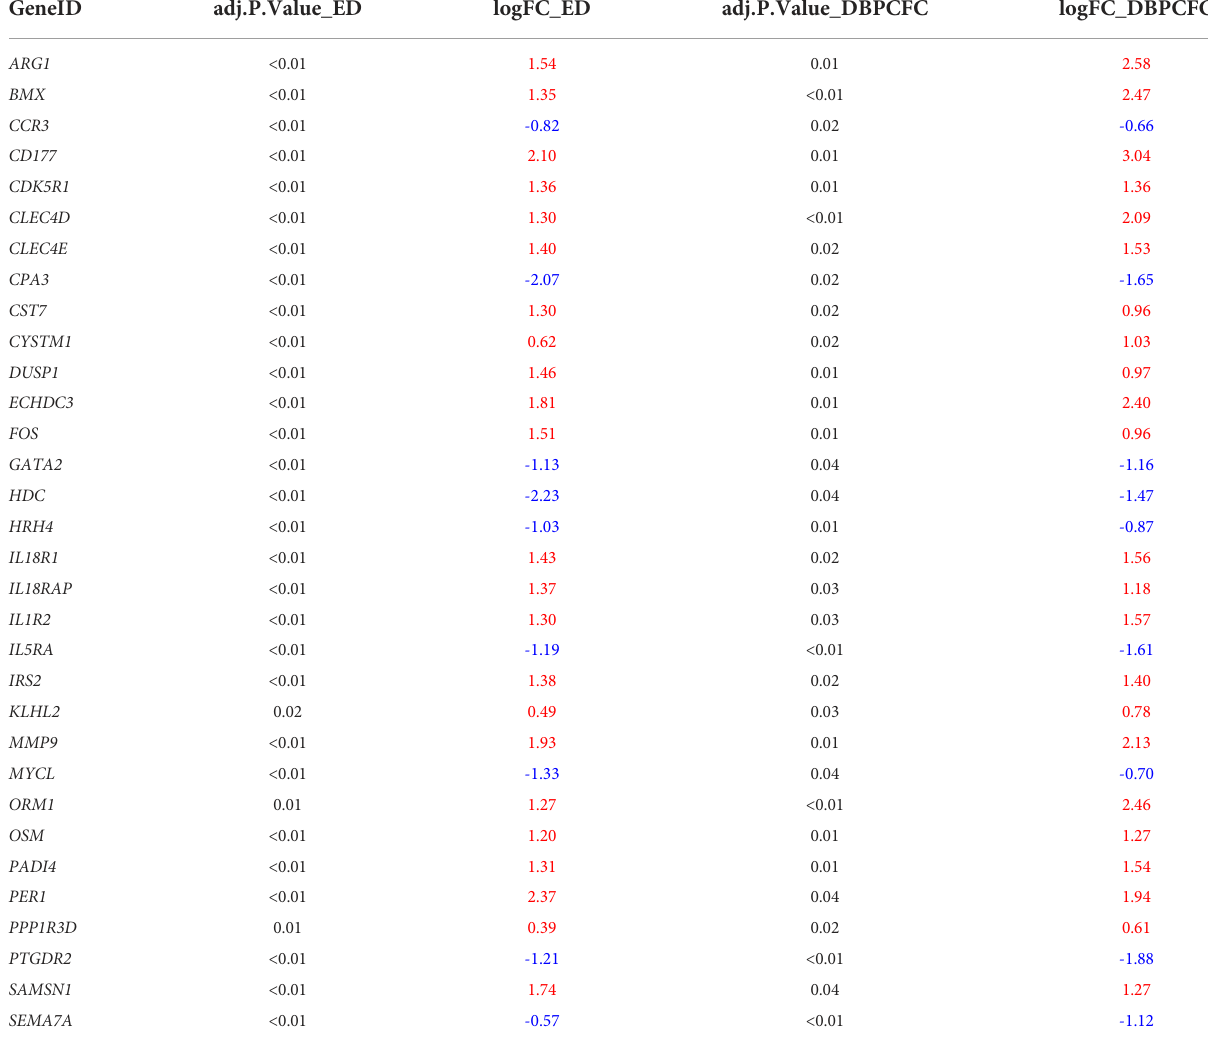
TABLE 3 Top differentially expressed genes (q < 0.1) in human anaphylaxis (ED and DBPCFC).